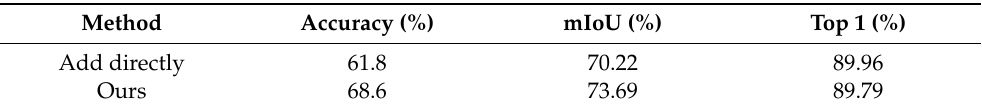
Table 10. Comparison of the different methods for multitask